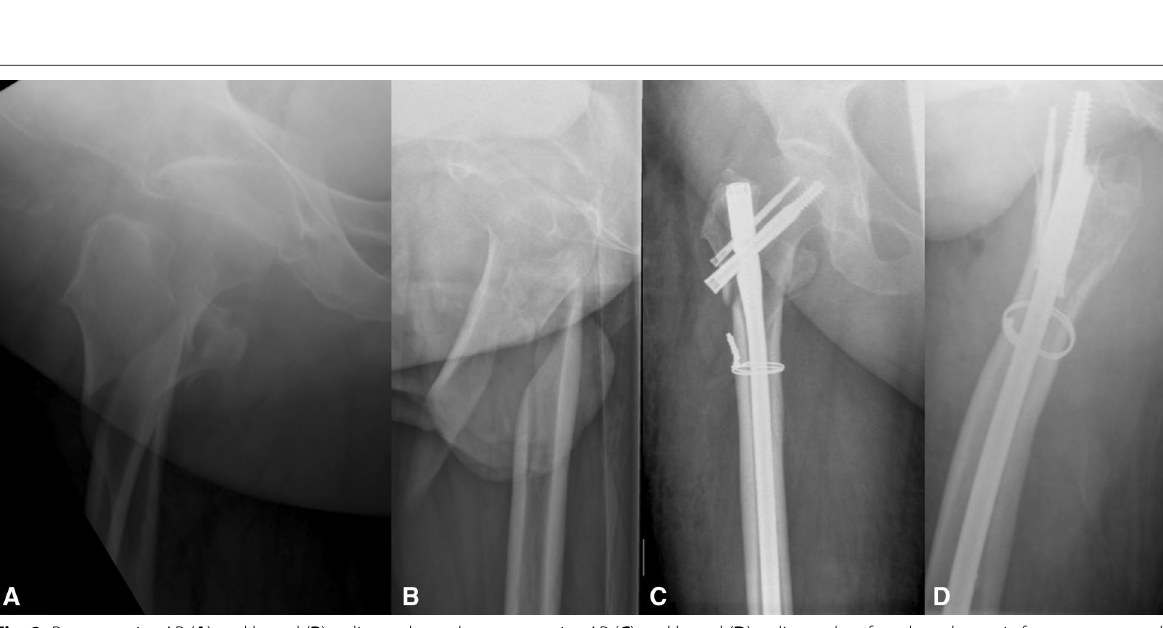
Fig. 2 Pre-operative AP ( A ) and lateral ( B ) radiographs and post-operative AP ( C ) and lateral ( D ) radiographs of a subtrochanteric fracture managed with an Affixus nail (with a proximal anti-rotation screw and cerclage wiring to assist